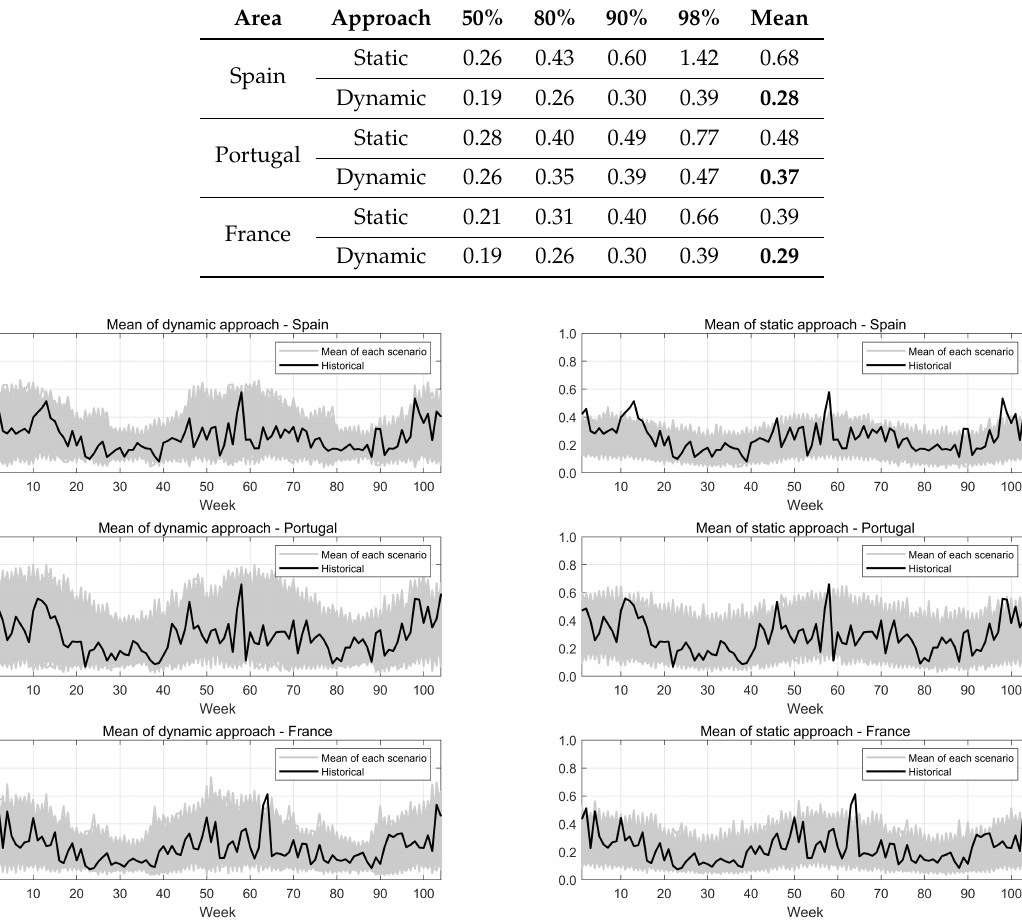
Figure 9. Comparison for mean on a weekly scale.